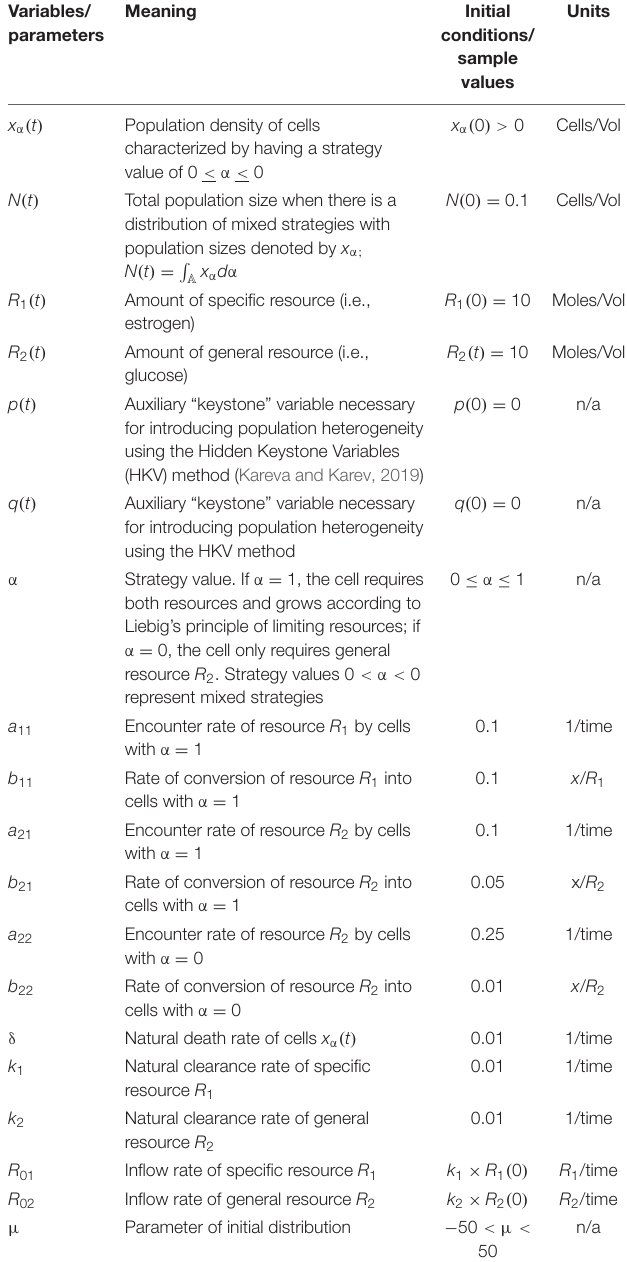
TABLE 1 | Variables and parameters used when there are 2 pure strategies, System (Rosenzweig, 1971), and when there is a distribution of mixed strategies, System (Oksanen and Oksanen,